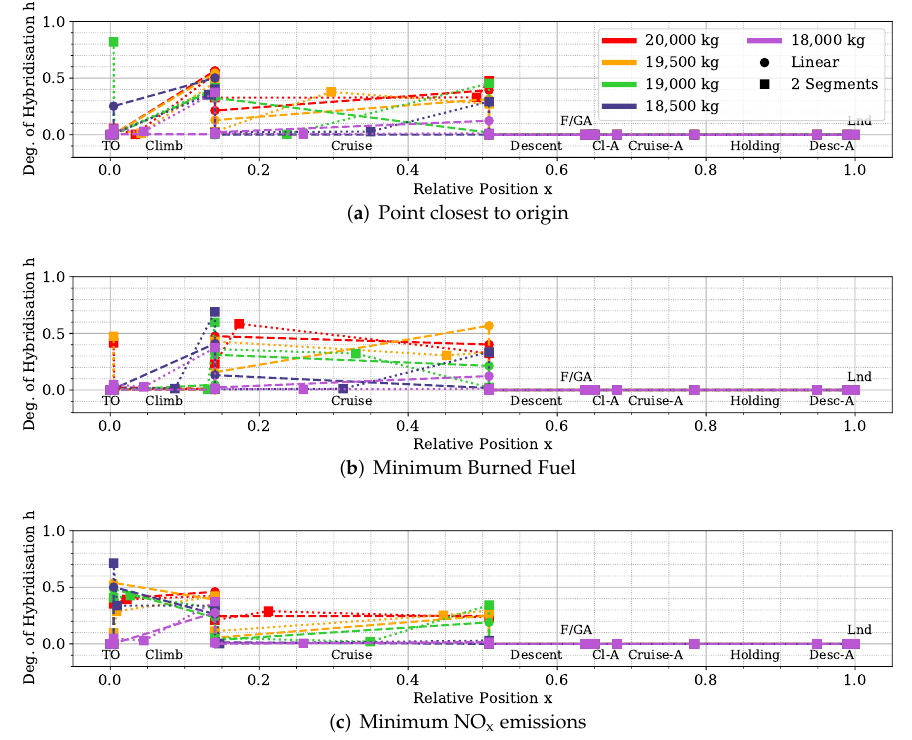
Figure A7. Optimal energy management strategies for different take-off mass constraint